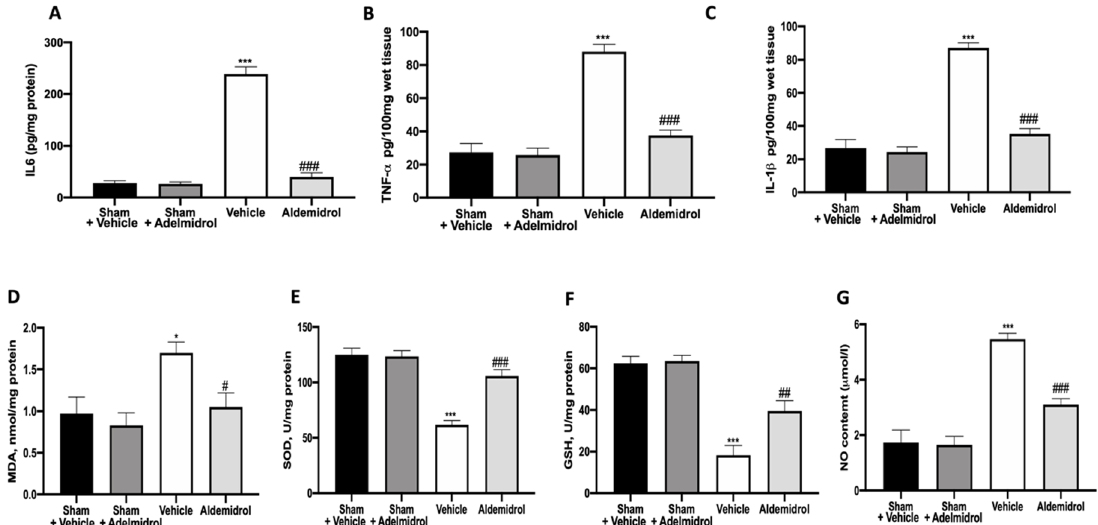
Figure 2. E ff ect of adelmidrol on lung tissue cytokine expression and oxidative stress: IL6 ( A ), TNF- α ( B ), and IL-1 β ( C ) expressions in lungs; malondialdehyde (MDA) ( D ), superoxide dismutase (SOD) ( E ), and glutathione (GSH) ( F ) levels; and nitric oxide (NO) content ( G ). * p < 0.05 vs. sham + vehicle, # p < 0.05 vs. vehicle, ## p < 0.01 vs. vehicle, *** p < 0.001 vs. sham + vehicle, and ### p < 0.001 vs. vehicle.